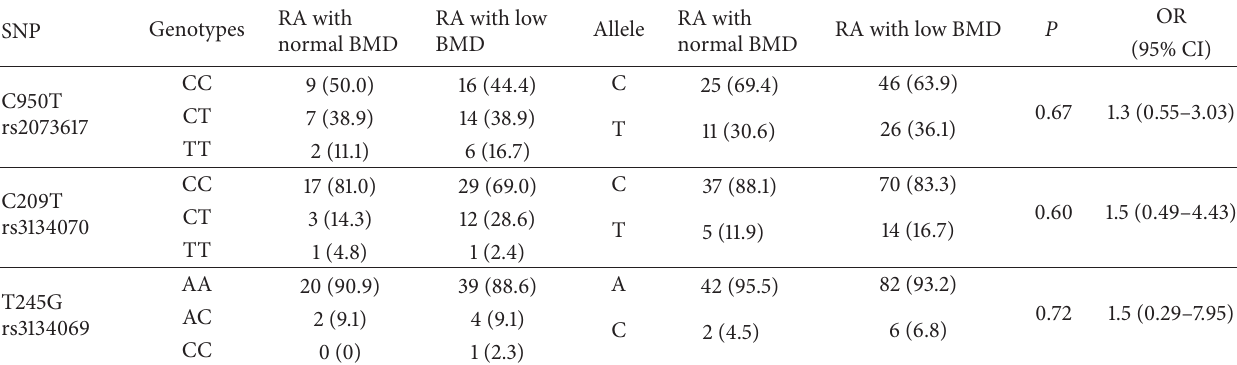
Table4:Genotypeandallelefrequenciesofpolymorphismsinthe TNFRSF11B (OPG)geneinrheumatoidarthritis(RA)patientswithnormal and low bone mineral density